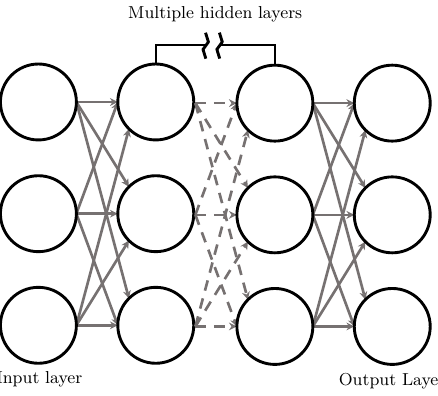
Figure 5. A simple schematic of an NN, with circles representing nodes and arrows representing how information is passed between them. The number of nodes in each layer is not necessarily